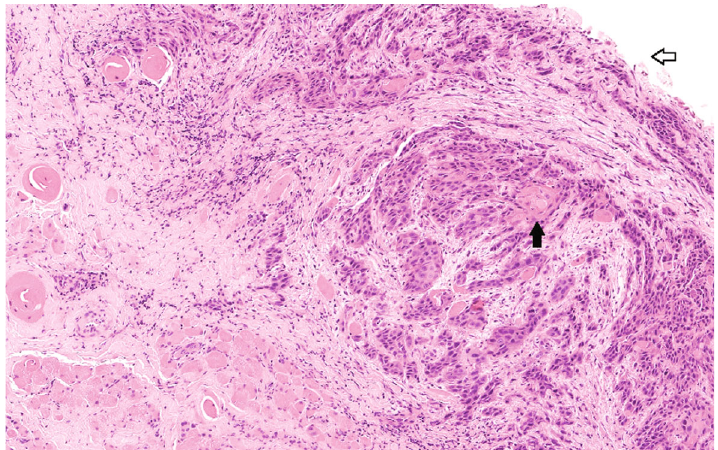
Figure 2: Representative sections of the surgical specimen of case 1 (surgical biopsy of bulbar urethra). Well-di ff erentiated squamous cell carcinoma with a horn-like appearance of pearls (full arrow) and surface erosion (empty arrow). The lesion invades the dermis and muscle tissue (staining with hematoxylin and eosin).